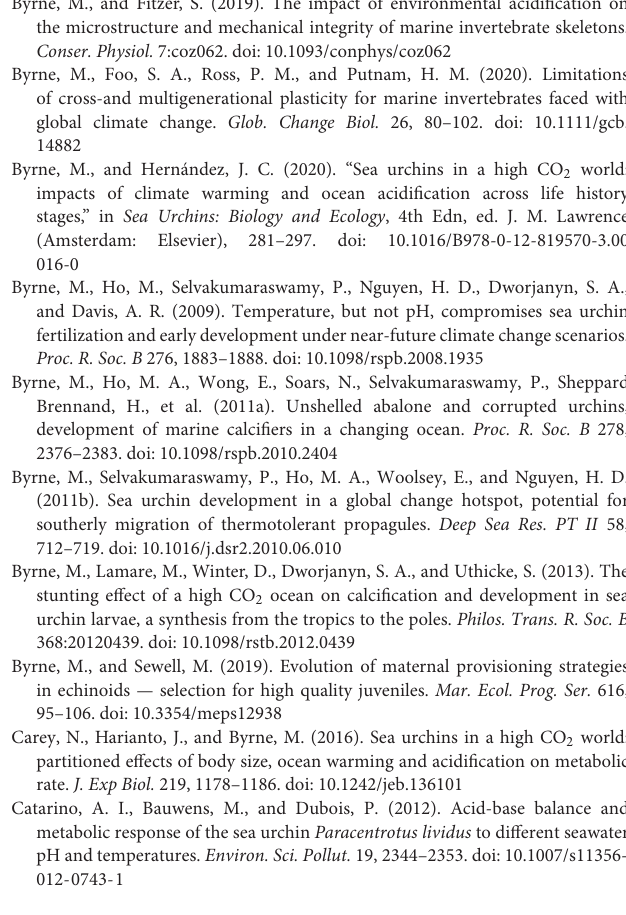
are plotted on the horizontal axis. Numbers are the EMM values and vertical lines connect the levels being compared. P -values smaller than 0.05 indicate significant differences between paired levels. The p -value scale is non-linear. Supplementary Figure 4 | Mean test diameter ( ± SE) of 14-day-old juvenile offspring of H. erythrogramma parents that were acclimated for 3 months at two temperature (black outline: ambient, red outline: + 2 ◦ C) and two pH T (white: 8.0, blue: 7.6) levels. The juveniles were reared in a range of temperatures (18–24 ◦ C). n = 960. Supplementary Table 1 | Carbonate system conditions ( ± SD) during the 22 weeks of acclimation of Heliocidaris erythrogramma in six treatments of three temperature (ambient, + 2 ◦ C, + 3 ◦ C) and two pH T (8.0, 7.6) levels. A T , total alkalinity; DIC, dissolved inorganic carbon, (cid:127) Ca and (cid:127) Ar, calcite and aragonite saturation states, respectively. n = 6. Supplementary Table 2 | Weekly, sampling-averaged temperatures ( ◦ C + SD) for three temperature profile treatments (ambient + 0 ◦ C, elevated + 2 ◦ C and + 3 ◦ C), logged over 22 weeks of acclimation for the sea urchin Heliocidaris erythrogramma . Temperatures were adjusted weekly according to the mean SST profile determined from 5 years of in situ data ( Supplementary Figure 1 ). Supplementary Table 3 | Carbonate system conditions ( ± SD) in offspring treatments of four temperatures (18 ◦ C, 20 ◦ C, 22 ◦ C, 24 ◦ C) and two pH T levels (8.0, 7.6). A T , total alkalinity; DIC, dissolved inorganic carbon, (cid:127) Ca and (cid:127) Ar, calcite and aragonite saturation states, respectively. n =